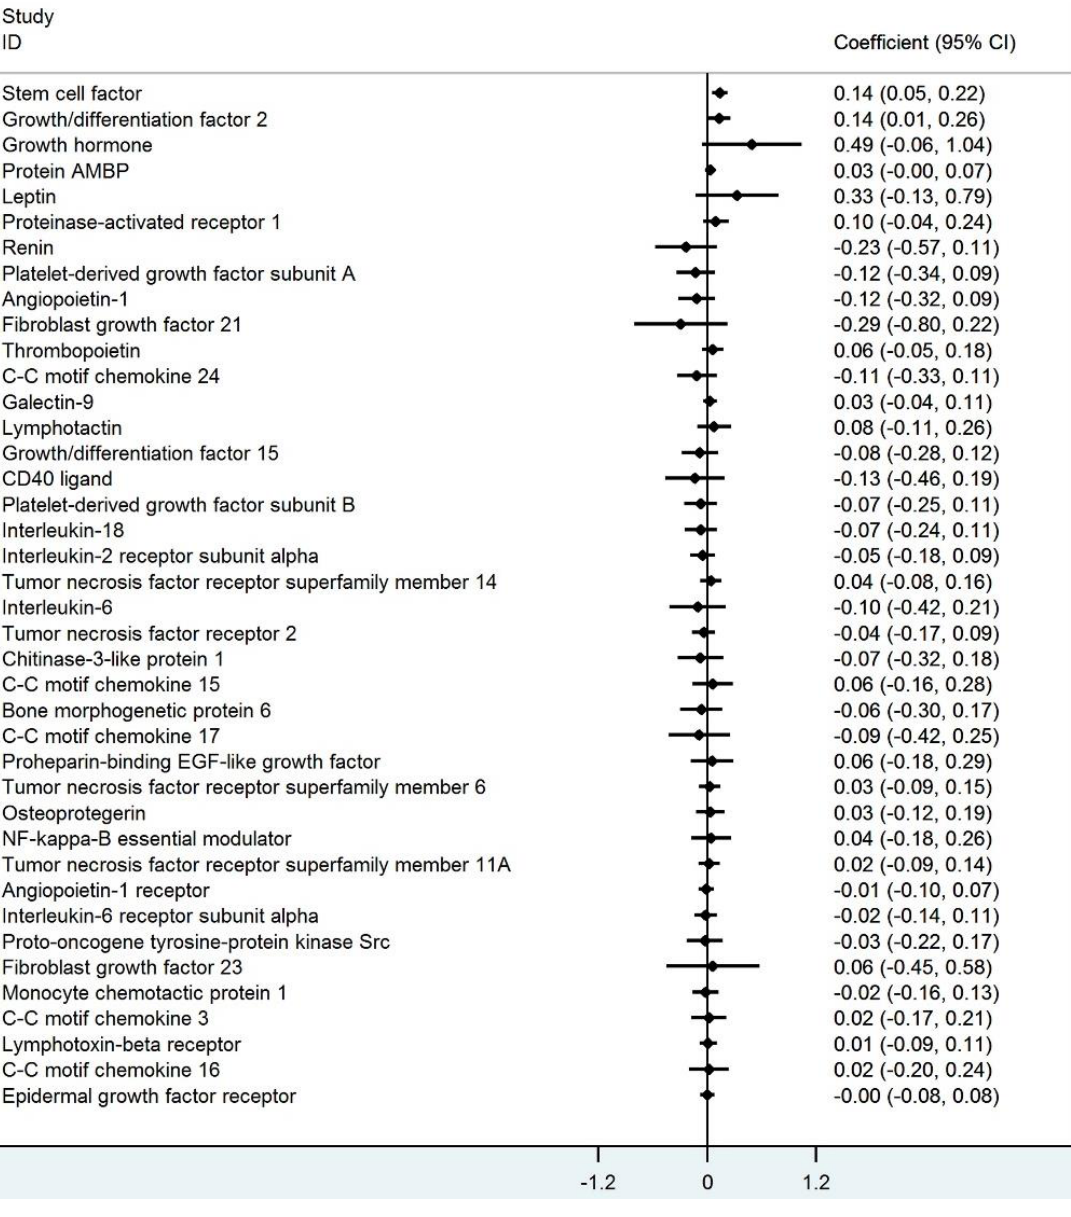
Figure 2. The association between Indole-3-acetic acid and 40 mitogen-activated protein kinase cascade associated proteins in linear regression models with age and sex adjustment.